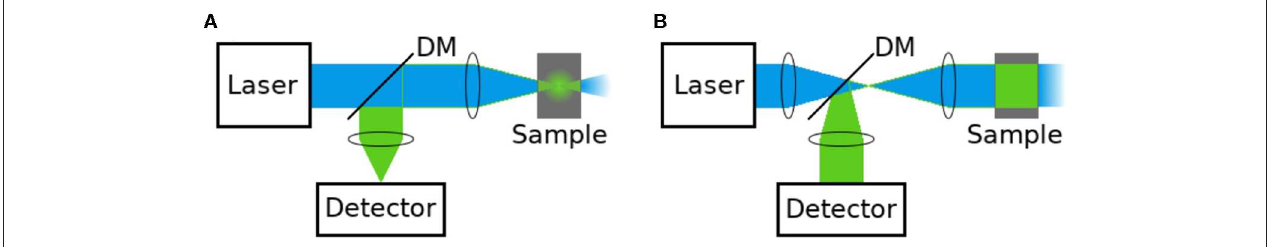
FIGURE 10 | Schematic diagram of the acquisition principle for (A) scanning and (B) wide-field FLIM. (A) In scanning FLIM, a focussed laser beam is raster-scanned over the image pixel by pixel to excite the fluorescence, and the photon arrival timing is performed with a point detector, separately in each pixel. (B) In wide-field FLIM, the entire sample is illuminated with a collimated excitation beam to excite the fluorescence, and the photon arrival timing is done with a position-sensitive detector. DM is dichroic mirror.